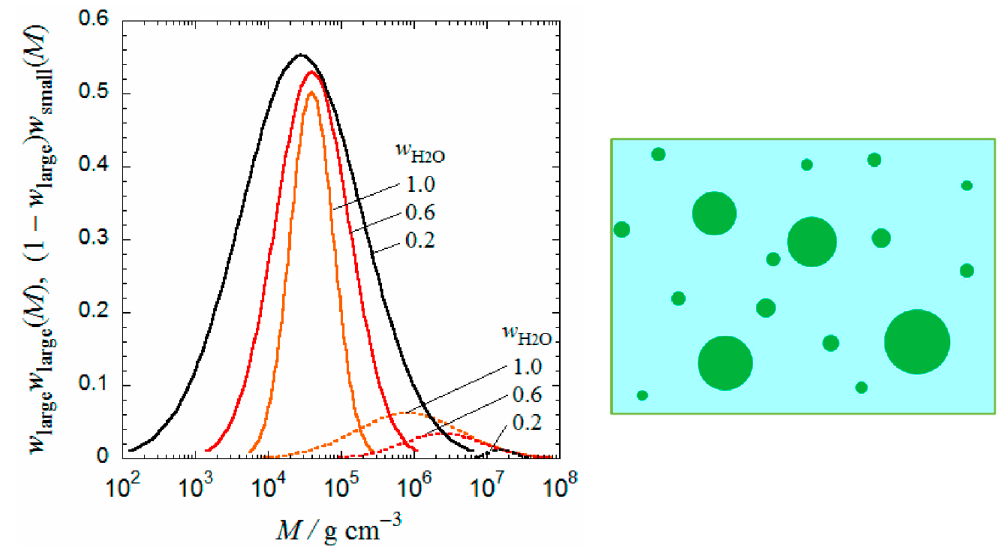
Figure 7. Weight fractions (1 − w large ) w small ( M ) (solid curves) and w large w large ( M ) (dotted curves) of the fraction with M for the small and large components, respectively, calculated parameters shown in Figure 6. Right Panel, schematic diagram of the bidisperse spherical particles model.